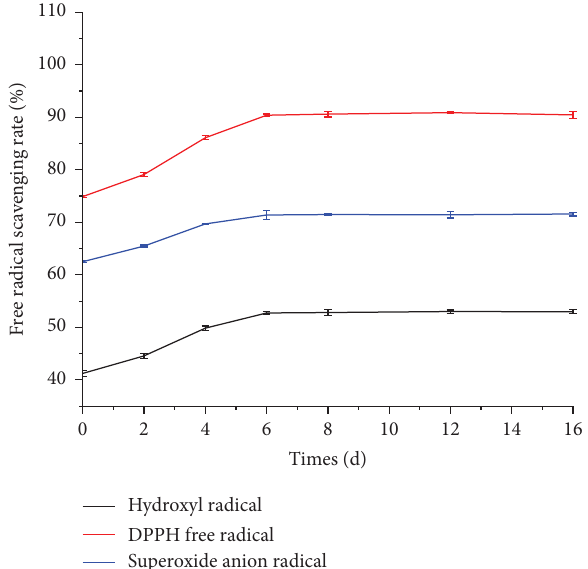
Figure 5: Changes in antioxidant ability of ginseng enzymes during